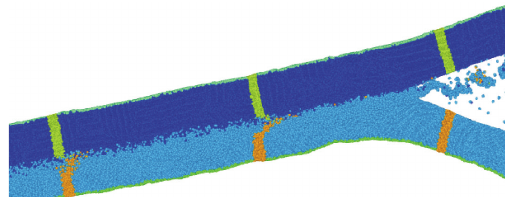
Figure 4: Direction of the jet in the collision of a copper plate (top) and an aluminum plate (bottom) simulated using a molecular dynamics model [14].